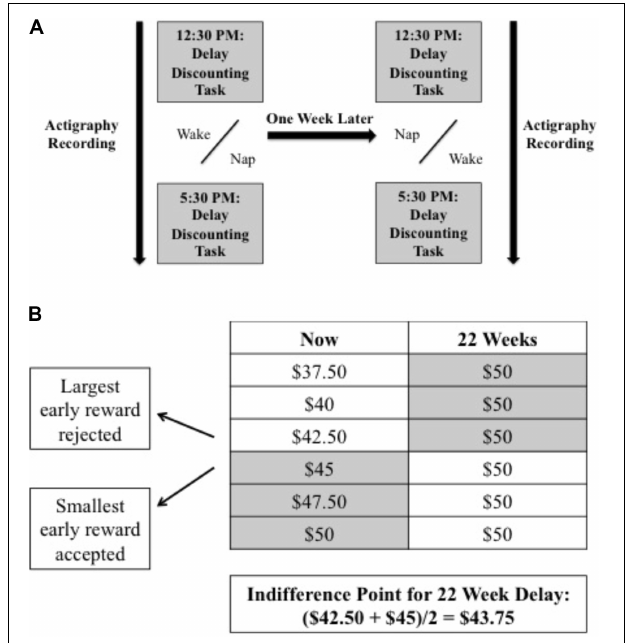
FIGURE 1 | Experimental design indicating (A) study procedures (gray bars indicate time points when the delay discounting task was performed) and (B) a sample choice (22-week delay) and respective indifference point calculation. Shaded cells represent participant’s choice between the now and later option.